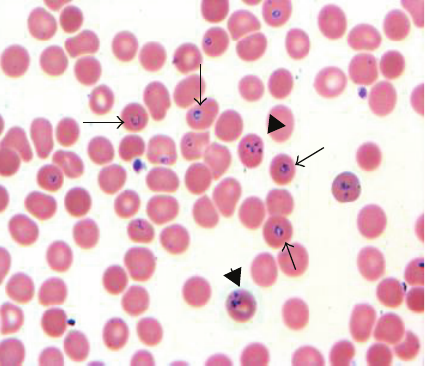
Figure 1: Red blood cells contain ring forms of B. microti (arrow) and tetrad (Maltese cross, arrow head), 1000x.